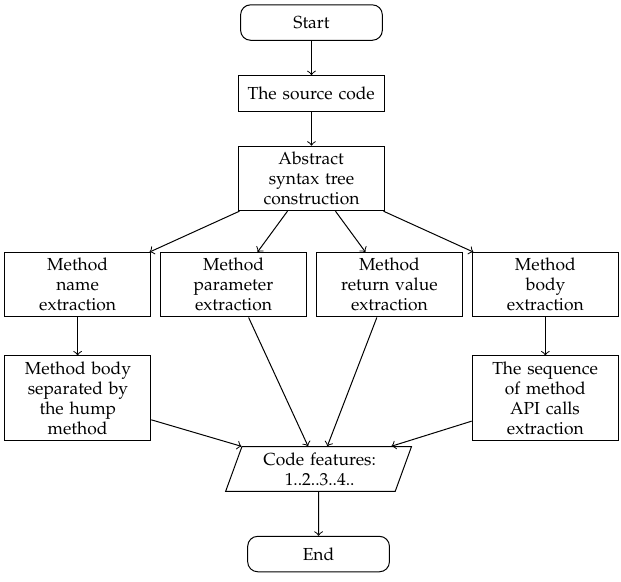
Figure 3. Code Annotation